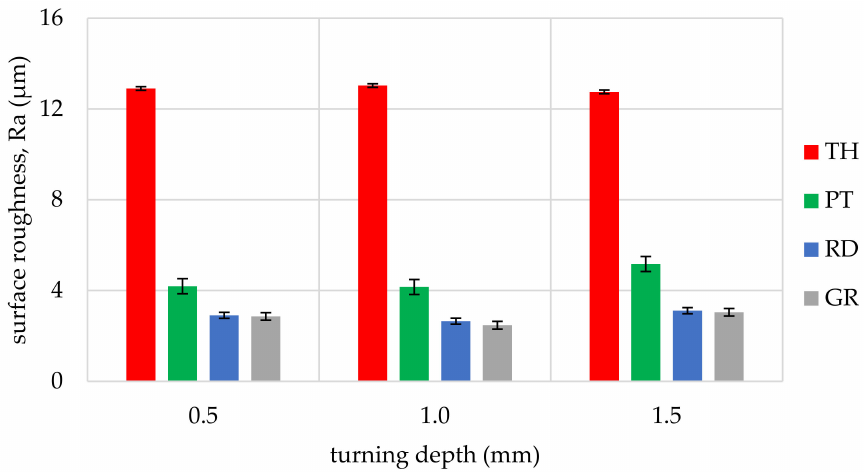
Figure 6. Influence of turning depth and type of cutting insert on surface roughness of West African Ebony, Diospyros crassiflora (EB).